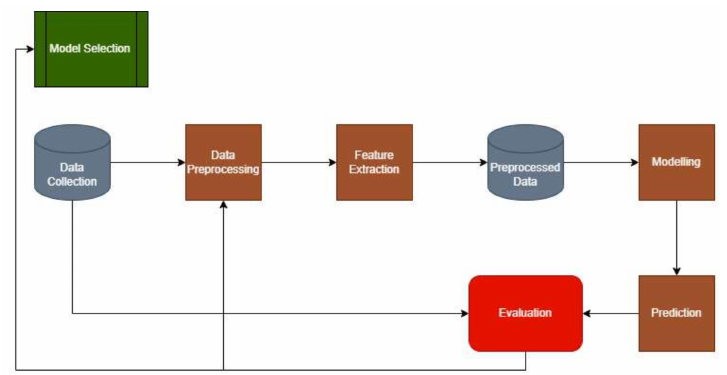
Figure 4. Model architecture for the analysis.